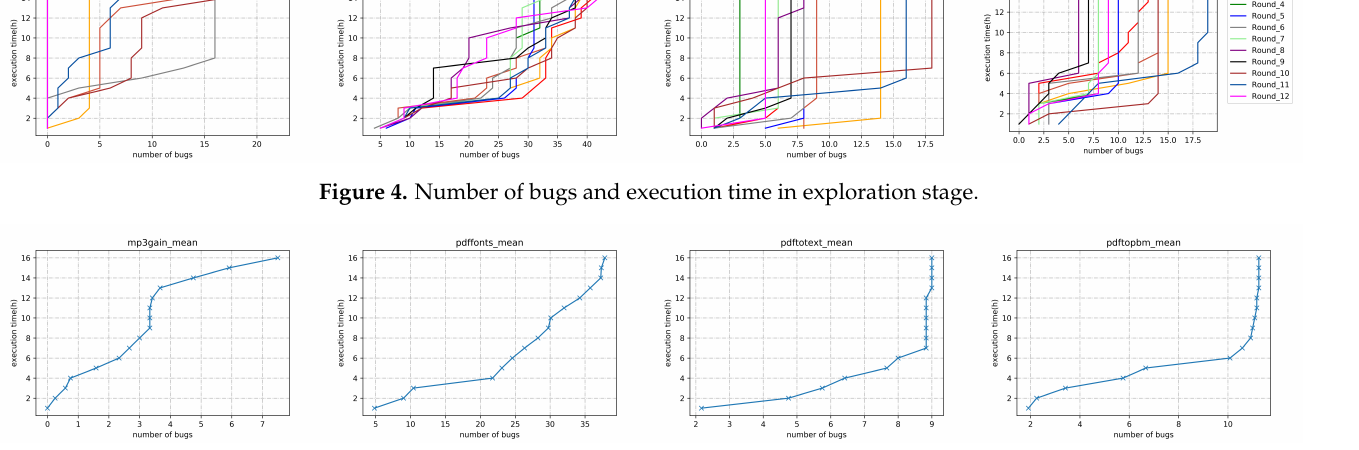
Figure 5. Average number of bugs and execution time in exploration